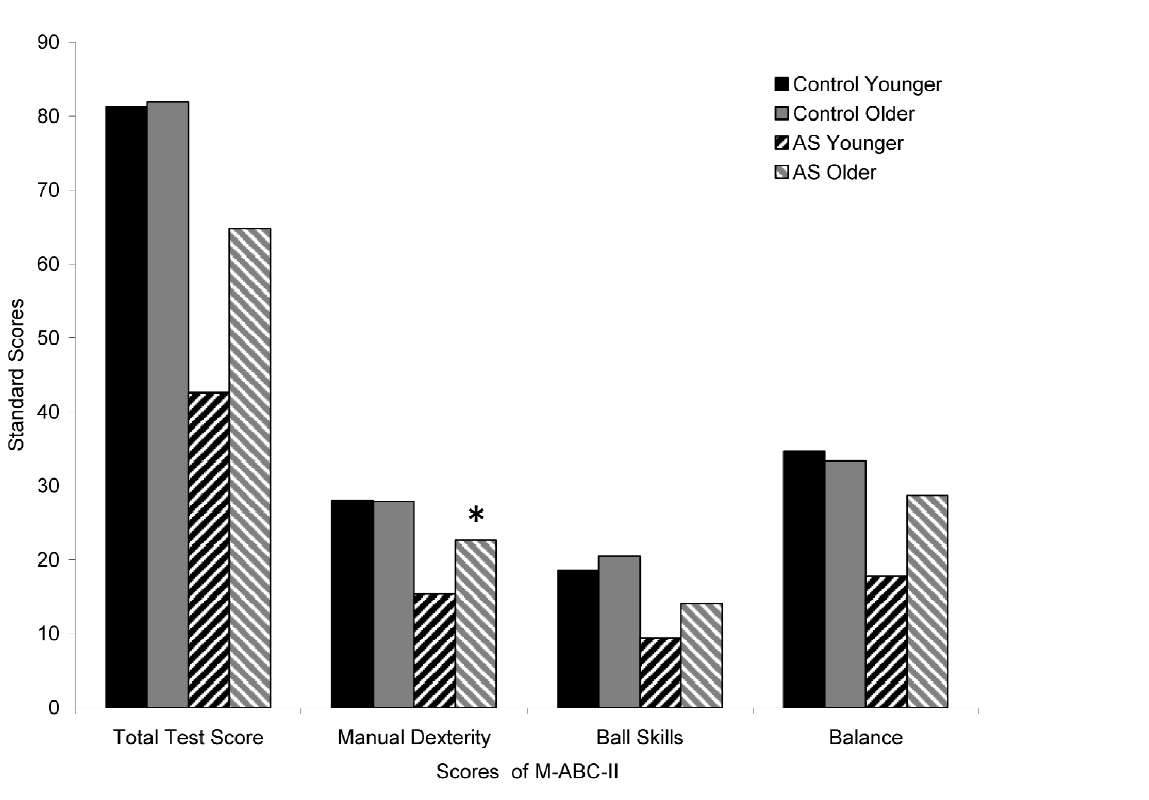
Figure 3. Mean component- and total test scores of the M-ABC-II for both younger (n = 15) and older group (n = 15) within the group with AS and the control group.